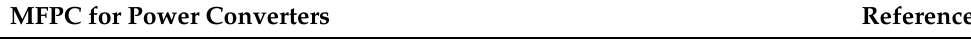
Table 1. Research papers on the application of model-free predictive control in power converters.